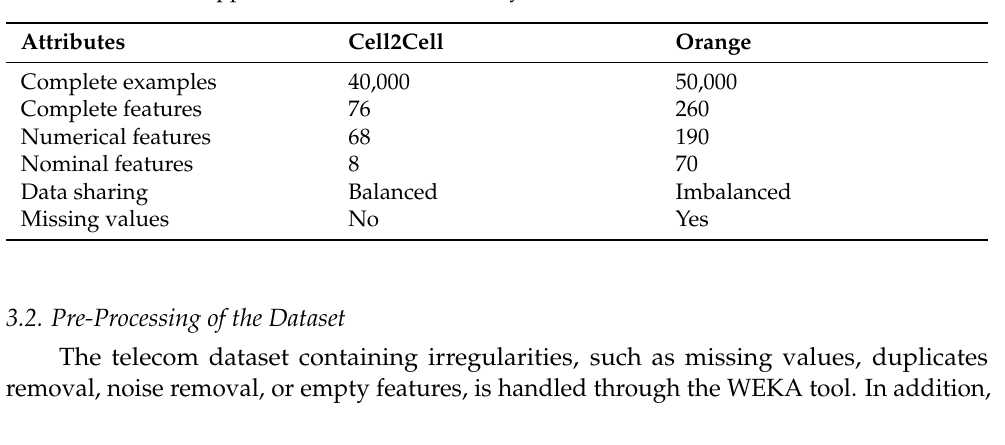
Table 1. Features of applied databases for this